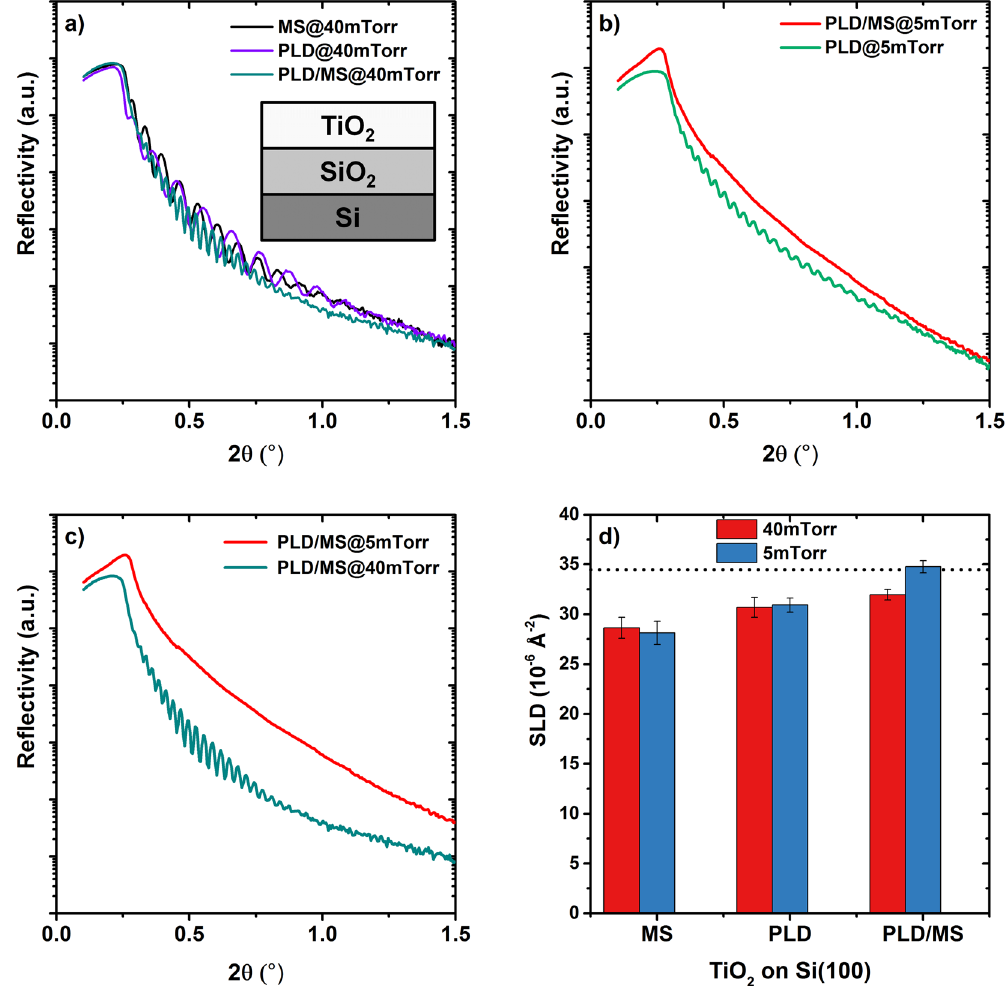
Figure 4. Reflectivity of TiO 2 samples on Si(100) substrates. ( a ) XRR of the samples deposited at 40mTorr with the three different techniques. In the inset the model used for fitting the data: between the TiO 2 and Si layers it was necessary to add a thin layer of SiO 2 (size not in scale), consistent with the presence of a thin native oxide layer at the surface. ( b ) XRR of samples at 5 mTorr. ( c ) Comparison of the samples deposited with hybrid technique at two different pressure, 5 and 40 mTorr. ( d ) Scattering Length Density values for TiO 2 layers deposited with the three techniques (MS,PLD and hybrid MS/PLD) at two different pressures, 5 and 40 mTorr. The horizontal dashed line represents the tabulated SLD of bulk TiO 2 (34.46 × 10 − 6 Å − 2 ) 33